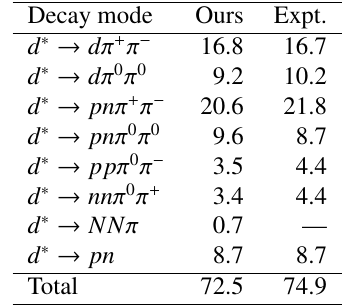
Table 2. Calculated decay widths of d (cid:3) (2380) (in MeV). Decay